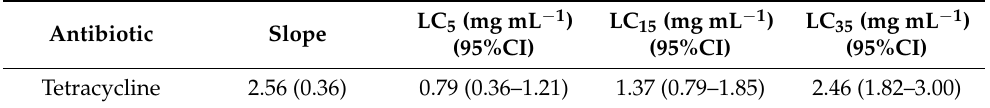
Table 1. Toxicity of tetracycline to T. pretiosum females.